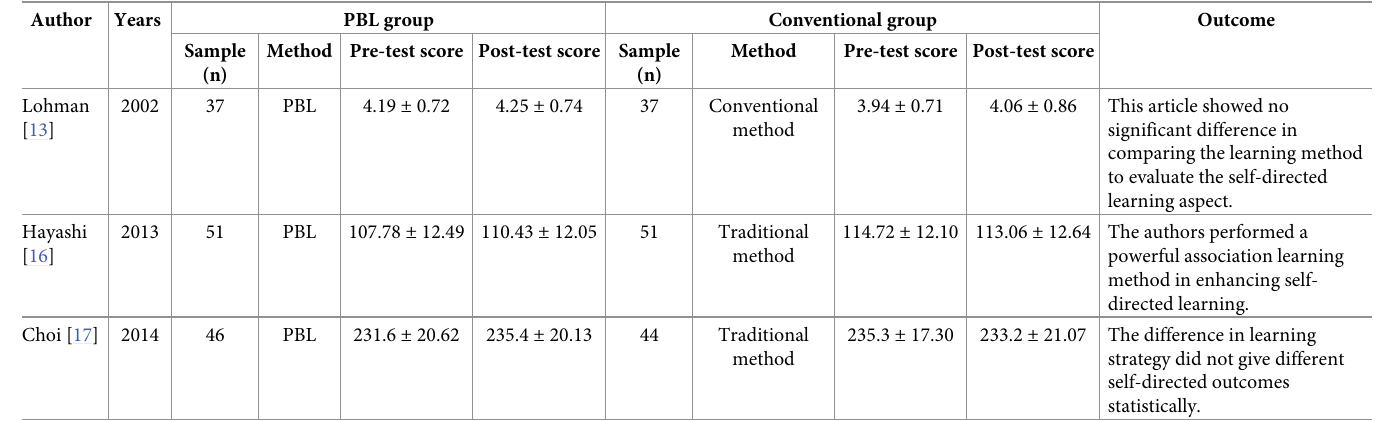
Table 4. Self-directed learning score analysis of both groups.